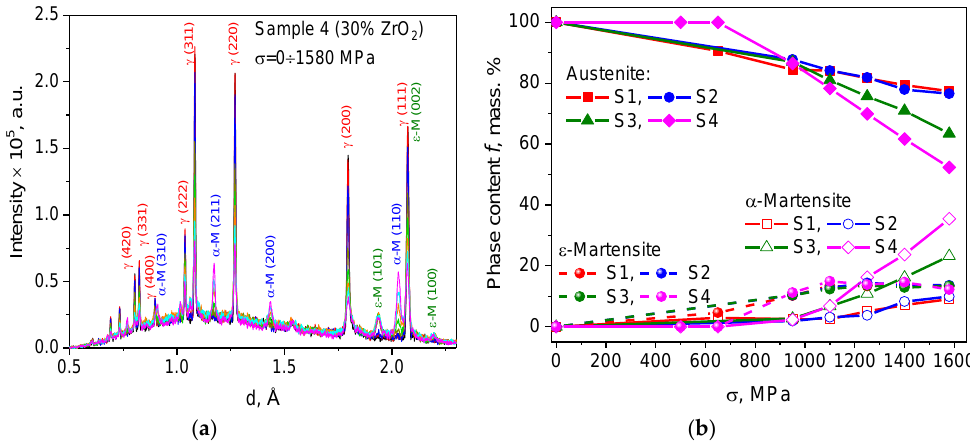
Figure 20. ( a ) The evolution of the diffraction pattern of TRIP-composite as a function of plastic deformation (sample S4, σ = 0 ÷ 1580 MPa). The Miller indices of the main peaks of austenitic and α’- and ε-martensitic phases are indicated; ( b ) Mass content of the observed phases vs. plastic deformation degree for all investigated samples, adapted from [45], with permission from © 2018 Springer.